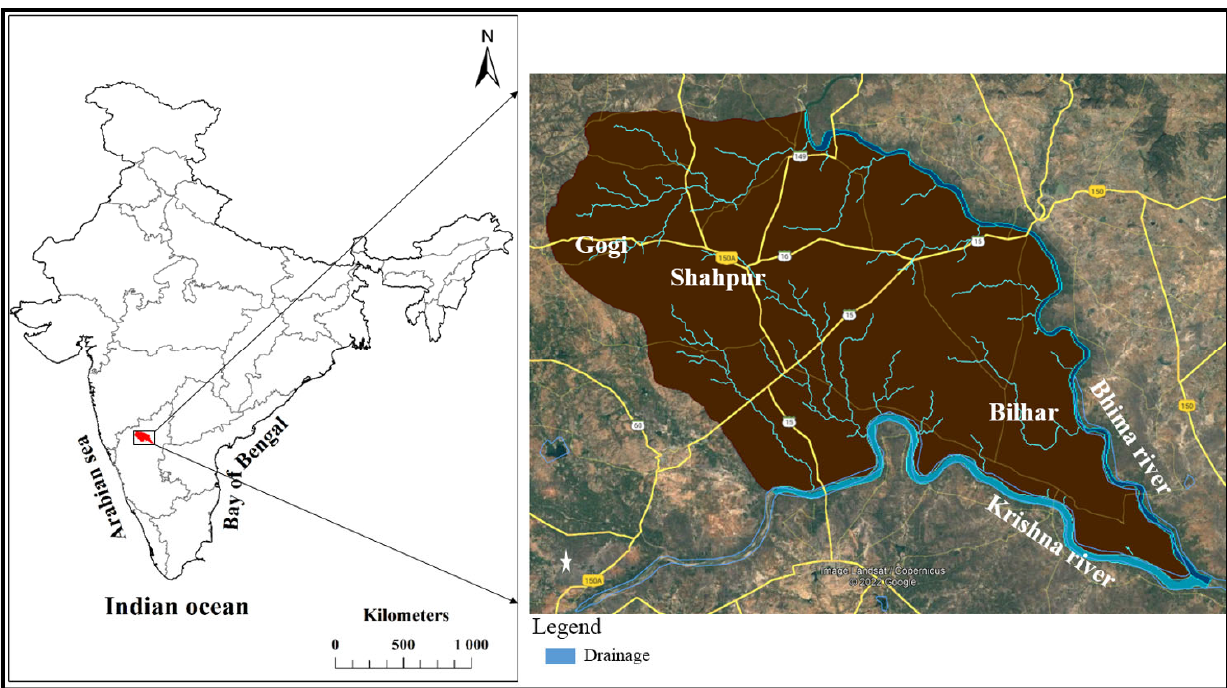
Figure 1. Location and drainage of the study area.